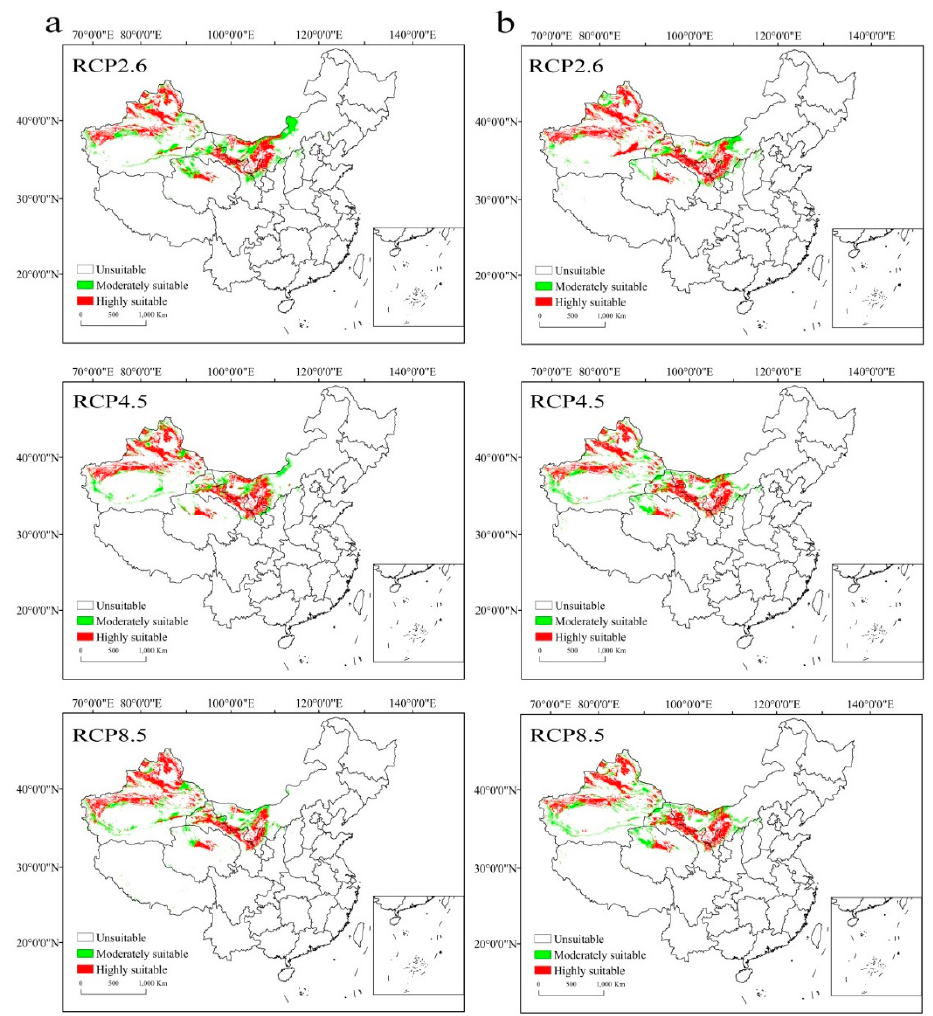
Figure 6. Comprehensive habitat suitability of H. ammodendron under di ff erent RCPs in 2050s ( a ), and 2070s ( b ).